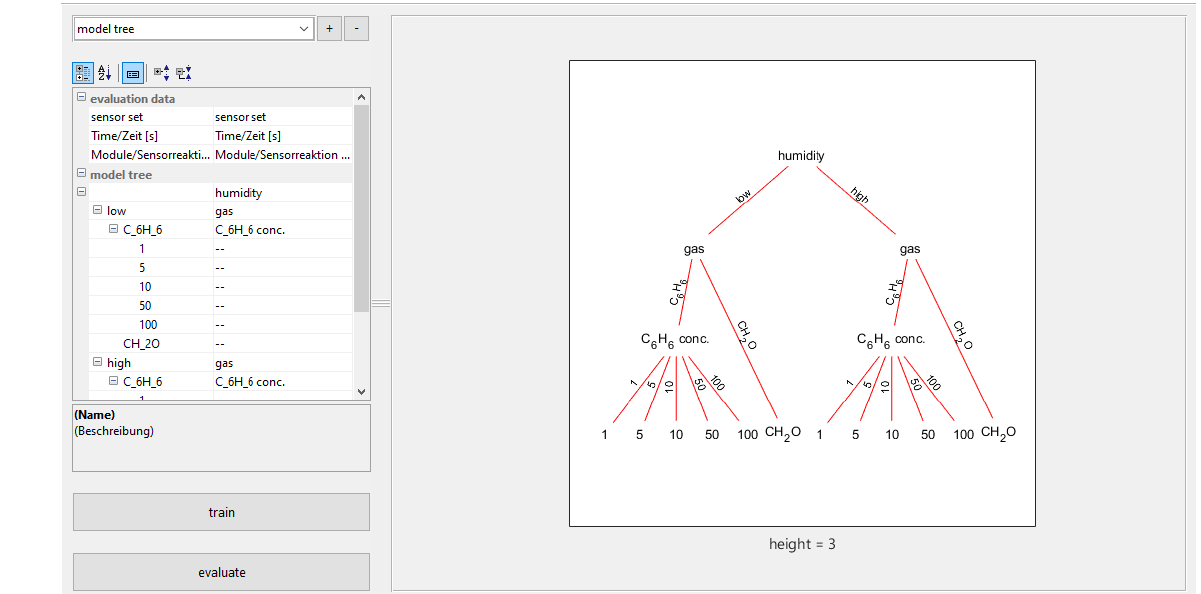
Figure 10. The hierarchical model module allows for the combination of previously defined models. They can be trained with the whole dataset or only with data relevant to the model, which can lead to specialization and better results. The hierarchy is shown as a directed graph with data flow along the edges and models as nodes.